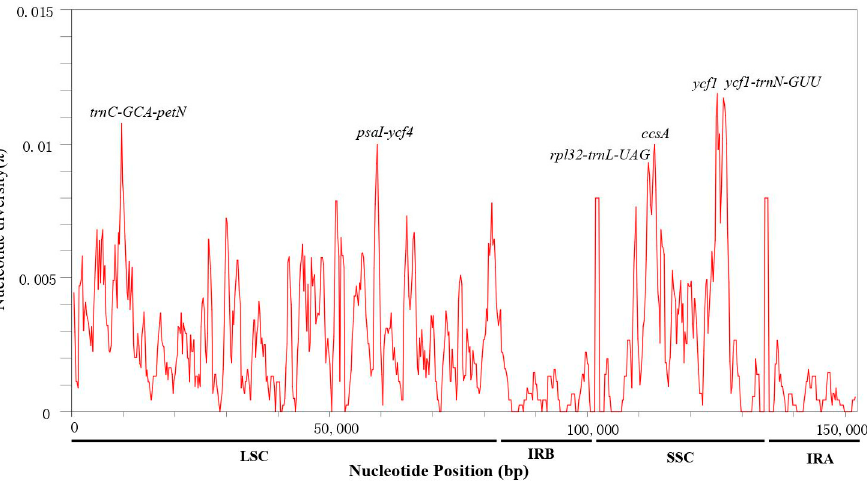
Figure 7. Sliding window analysis of the whole chloroplast genomes of 10 species of tribe Sene- cioneae. Window length: 800 bp; step size: 200 bp; X -axis: position of the midpoint of a window; Y -axis: nucleotide diversity of each window.